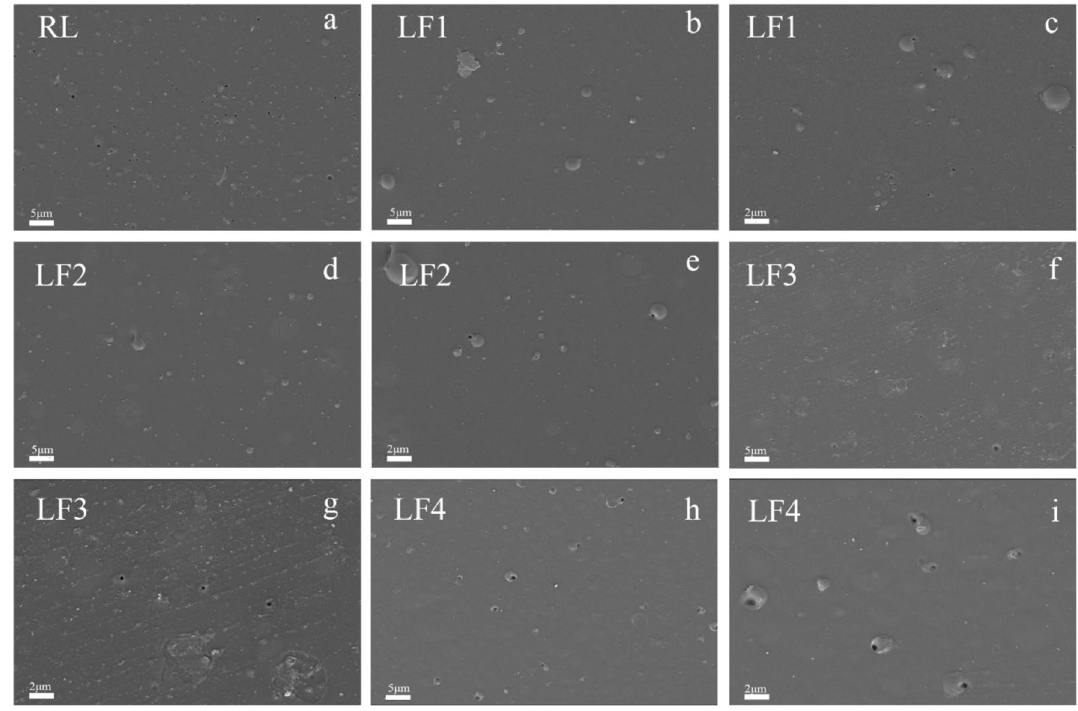
Figure 8. SEM images of membrane of appearance of RL and LF: ( a ) RL; ( b ) and ( c ) LF1; ( d ) and ( e ) LF2; ( f ) and ( g ) LF3; ( h ) and ( i )